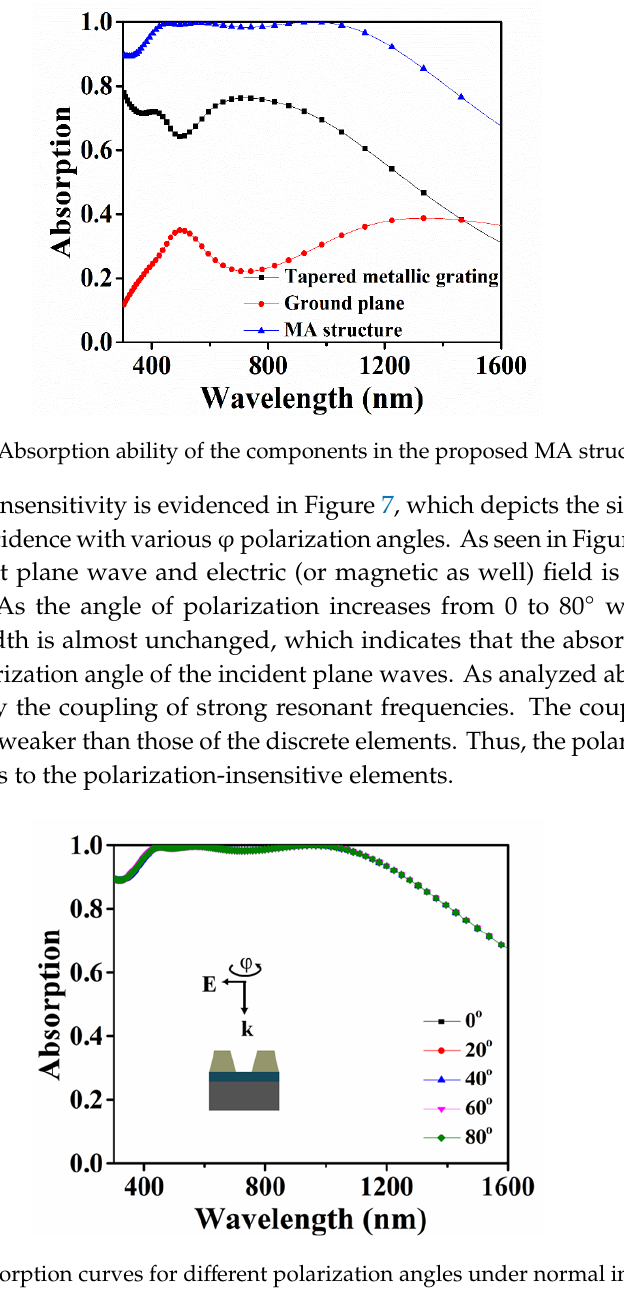
Figure 5. Absorption spectra as a function of various incident angles for ( a ) TE-polarization light and ( b ) TM-polarization light.